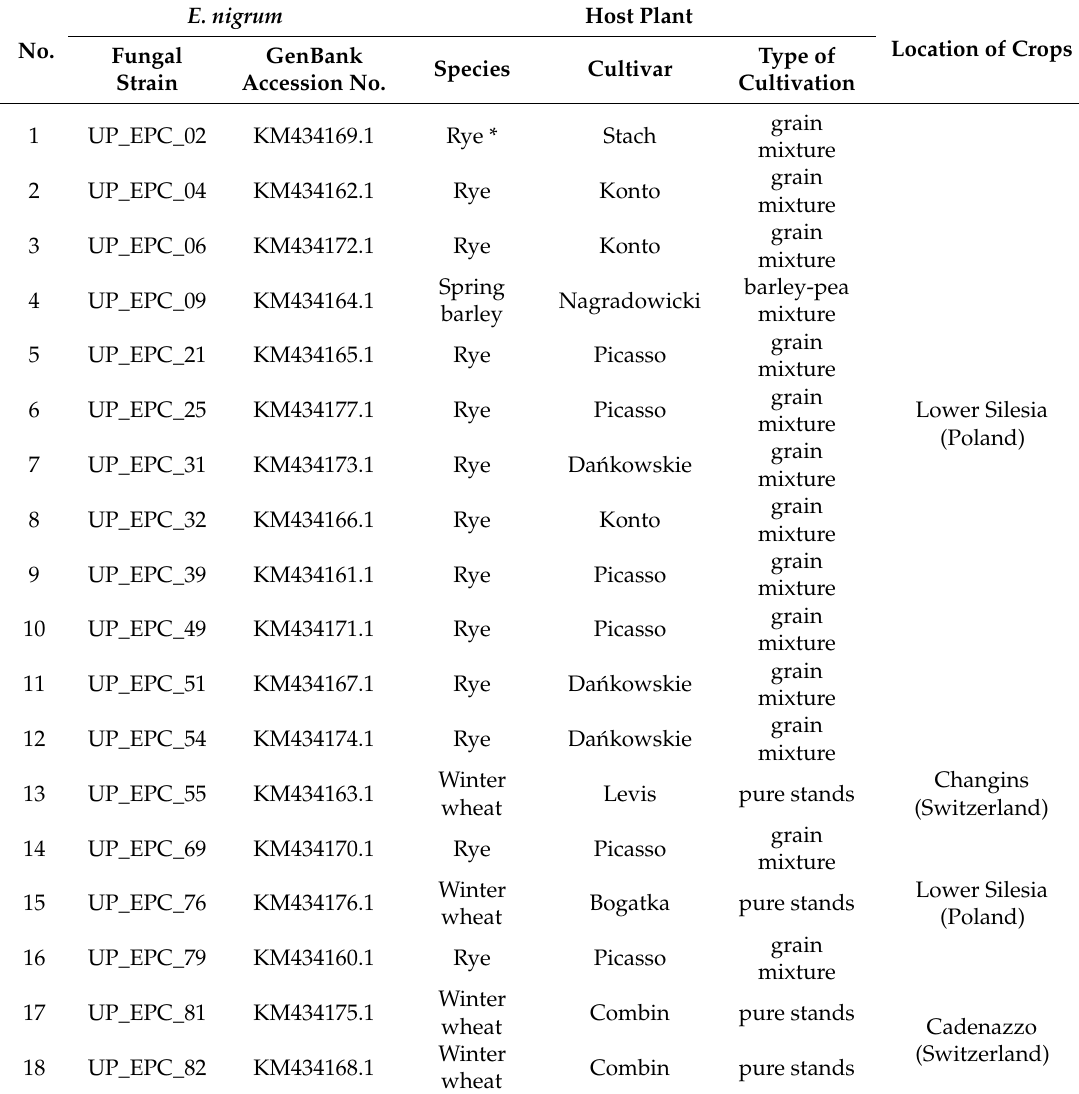
Table 1. Characteristics of E. nigrum strains used in the